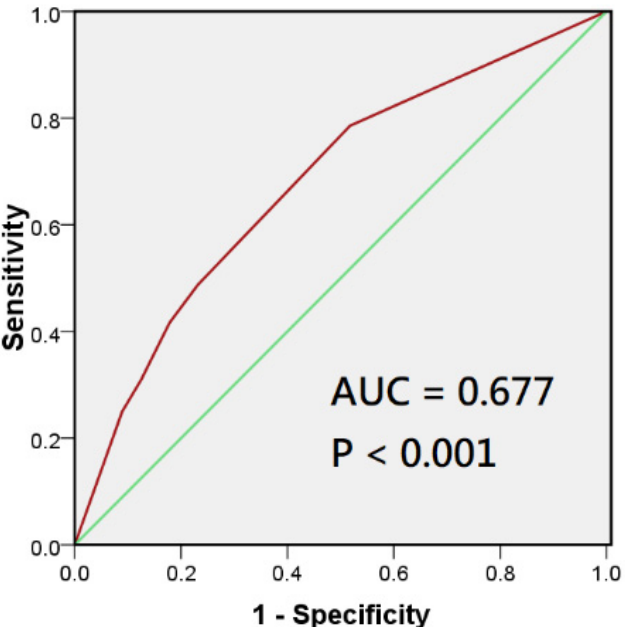
Figure 3. Receiver operating characteristic (ROC) analysis of the sensitivity and specificity of the prediction of carotid artery stenosis based on ASCVD risk score and calcium kidney stone.